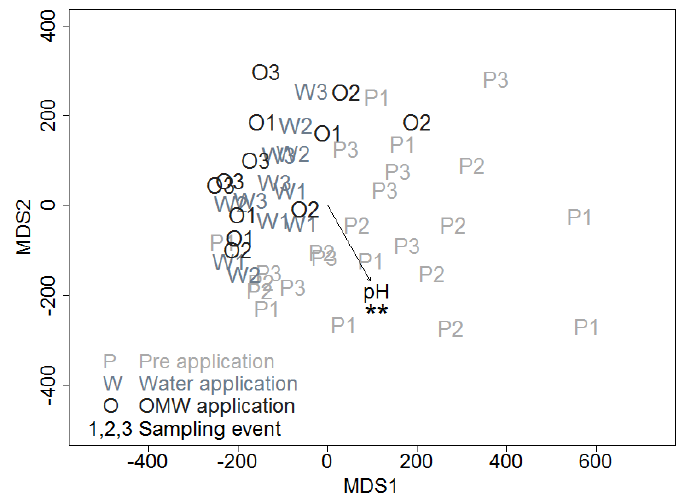
Figure 5. Non-metric multidimensional scaling based on the Oribatida and Collembola community in Bait Reema. Arrow of the explanatory variable pH points to the direction of the increasing gradient, the length is proportional to the correlation between the variable and the ordination. Ordinations are based on Bray-Curtis dissimilarity after Wisconsin double standardization of the community matrix. Asterisks code significant relationships ( ** p < 0.01) between community composition and environmental parameters. P, pre application; W, water application; O, OMW application at the 1st, 2nd and 3rd sampling